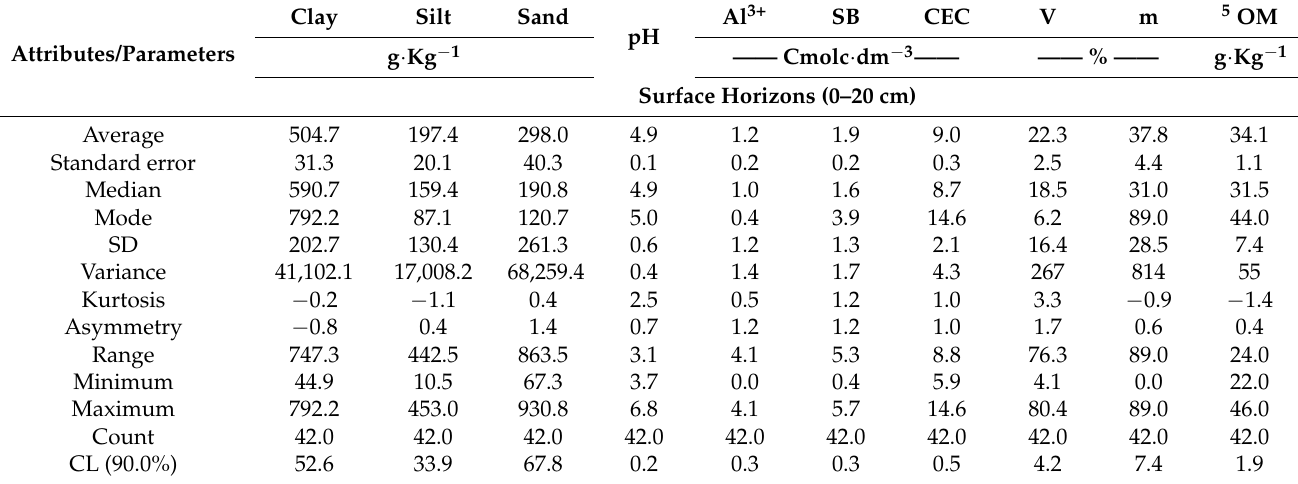
Table 1. Descriptive statistics of the studied surface soil